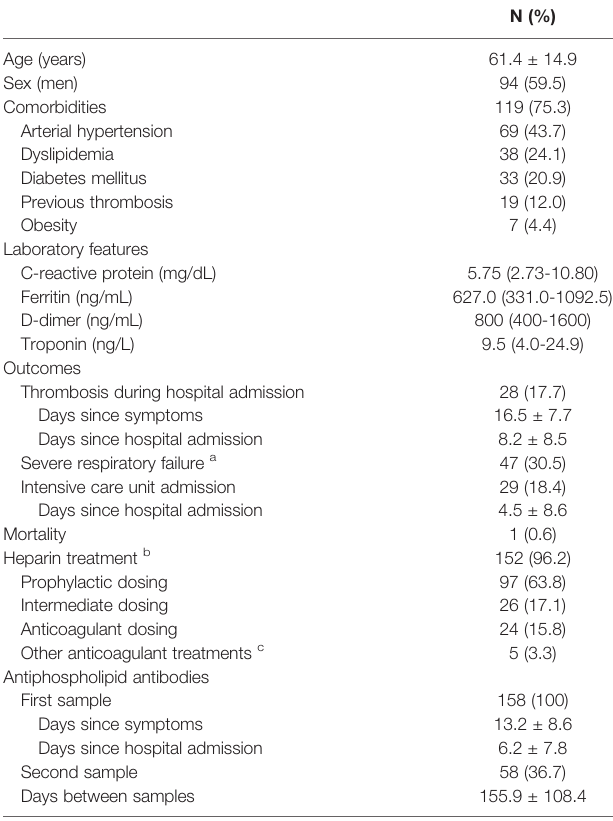
TABLE 1 | Demographic characteristics, comorbidities, laboratory features, and outcomes of the overall series of patients with